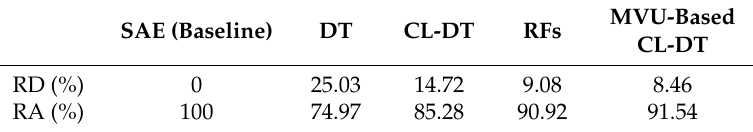
Table 5. The RD of classification results and RA in the 2nd test area.